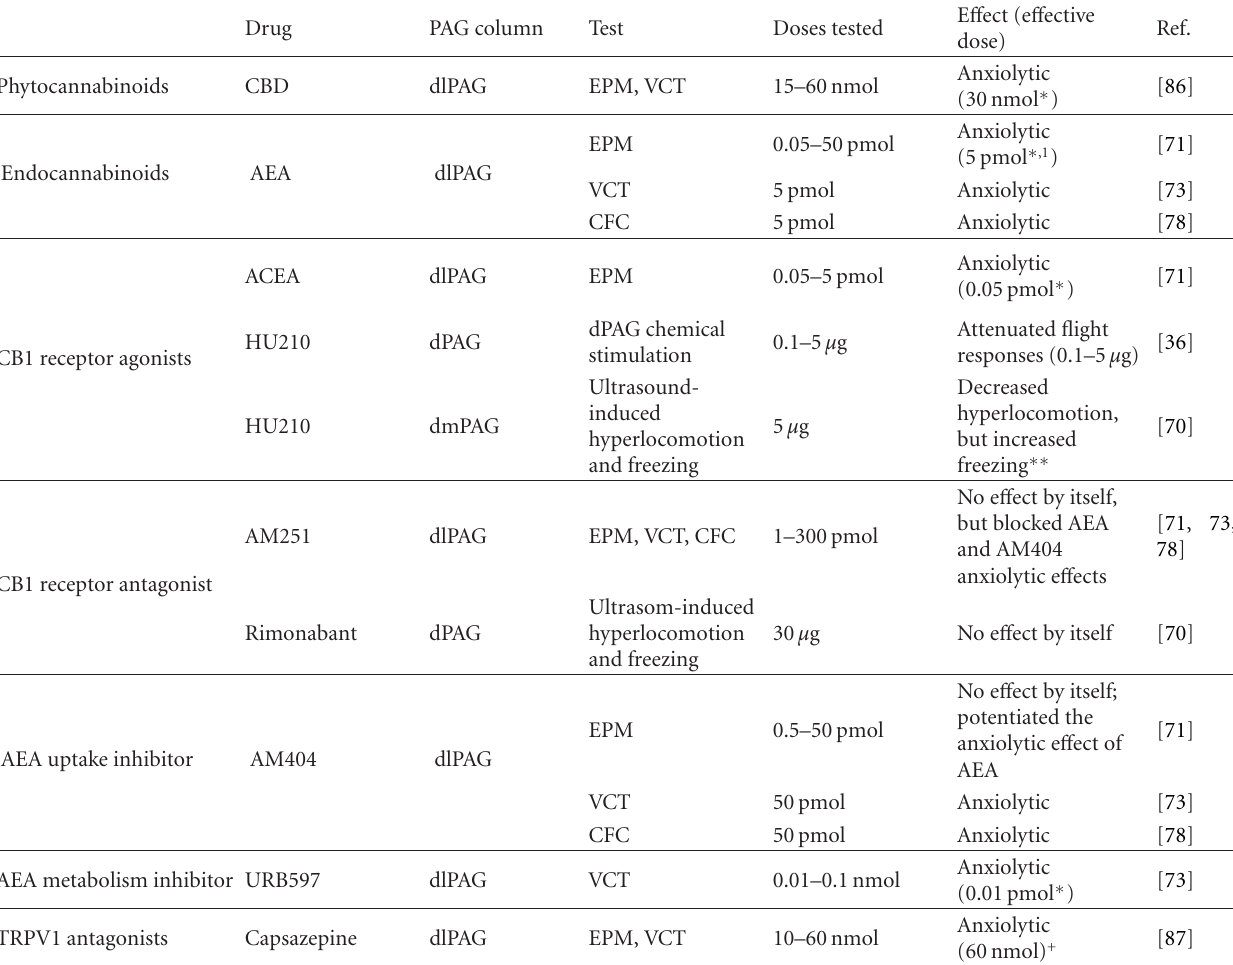
∗ Bell-shaped dose-response curve. Anxiolytic e ff ect blocked by AM251 (100pmol) and potentiated by AM404 (50pmol). + Capsazepine 10nmol turned the higher, ine ff ective dose of CBD (60nmol) into an anxiolytic one in the EPM [85]. ∗∗ Not blocked by rimonabant 30 μ